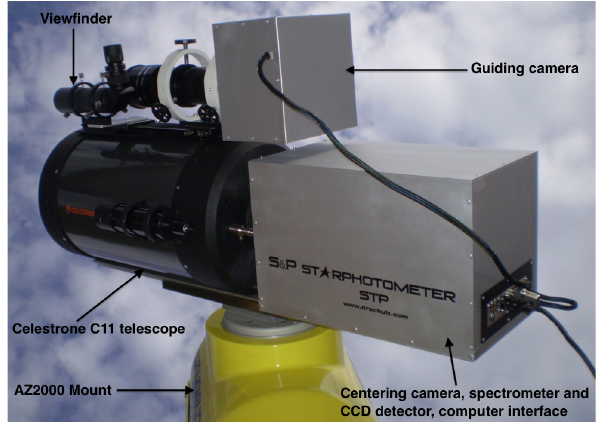
Figure 1. Principal components of SPSTAR star